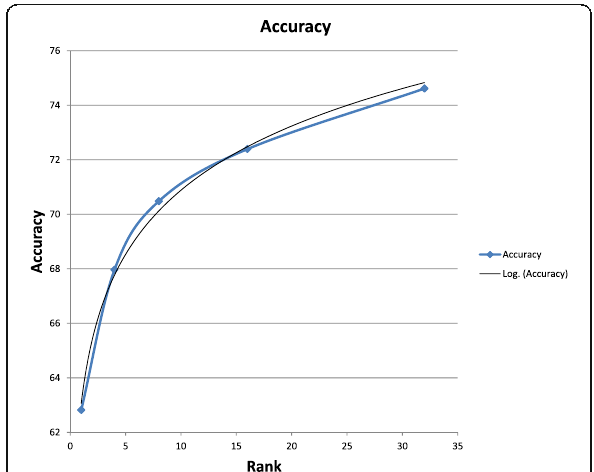
Fig. 6 Accuracy (AC) and Rank used for the data decomposition